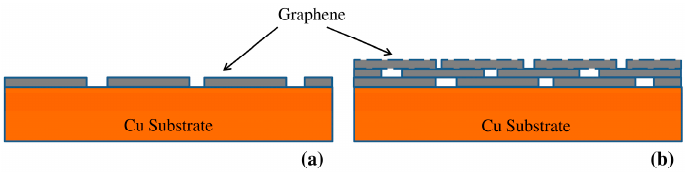
Figure 1. Schematics of: ( a ) single layer graphene with bare locations at the graphene domain boundaries; ( b ) multilayer graphene showing the graphene domain boundaries of inner layer to be masked by the immediate upper layer.